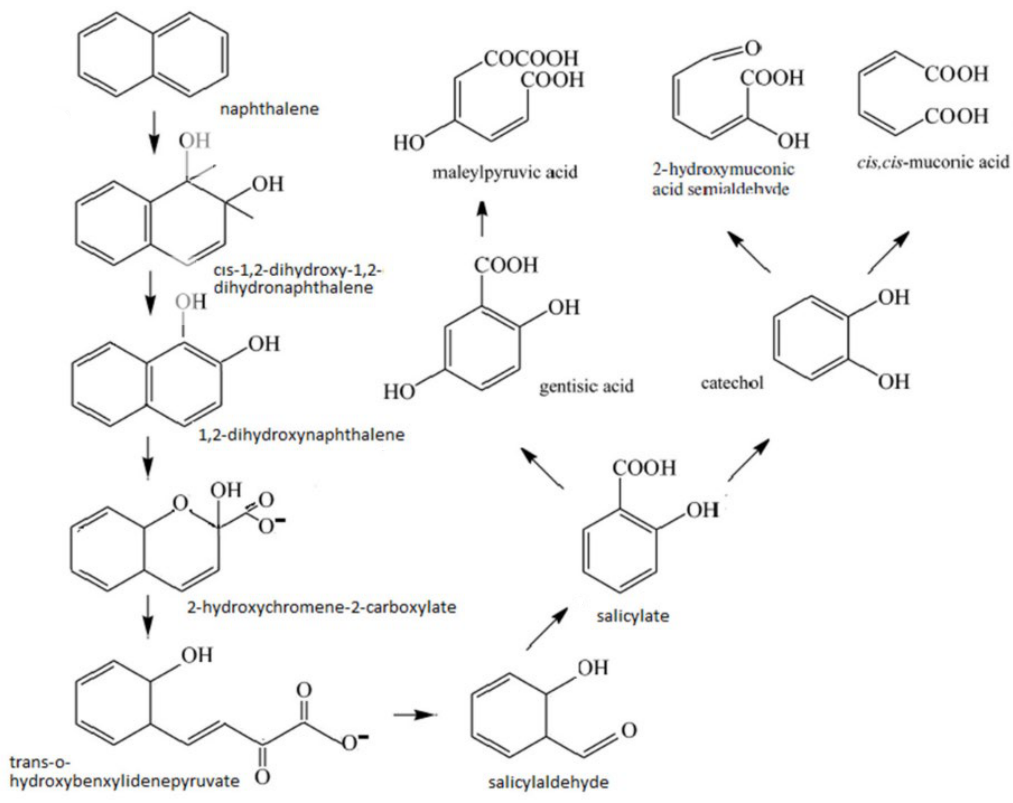
Figure 2. Biodegradation pathway of PAH by aerobic bacteria [63].